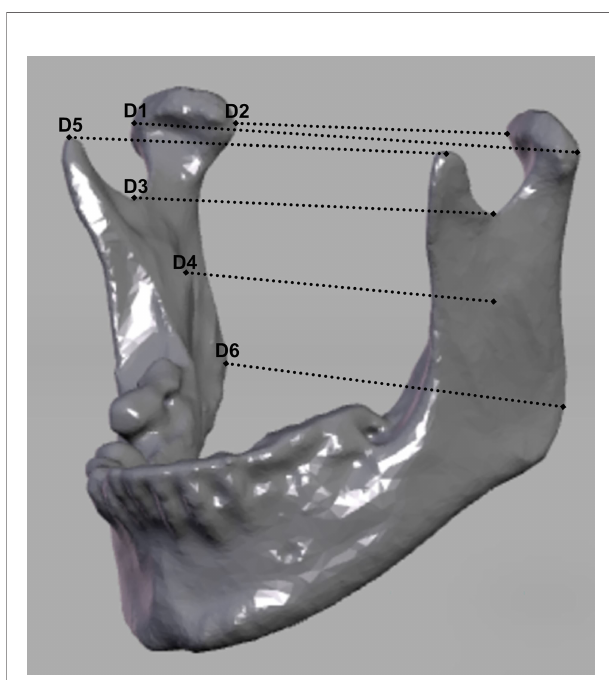
FIGURE 1 | Representation of the measurement distances. D1, lateralmost point of condyle mandibulae right to the lateralmost point of condyle mandibulae left; D2, medialmost point of condyle mandibulae right to the medialmost point of condyle mandibulae left; D3, most caudal point of the incisura mandibulae on the right to the most caudal point of the incisura mandibulae on the left; D4, foramen mandibulae on the right to the foramen mandibulae on the left, D5, processus coronoideus on the right to processus coronoideus on the left; D6, gonion on the right to gonion on the